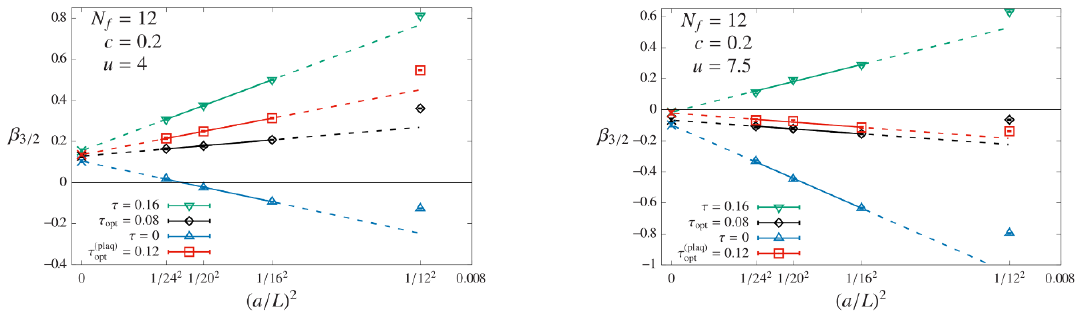
Figure 10 . Linear ( a=L ) 2 ! 0 extrapolations of the s = 3 = 2 discrete (cid:12) function for c = 0 : 2, at two values of u = 4 (left) and 7.5 (right) on either side of the IR (cid:12)xed point. In each plot we compare (cid:28) 0 = 0 and 0.16 to the optimal (cid:28) opt = 0 : 08, and also include results from the plaquette discretization of the energy density E ( t ) in eq. (2.3) at the corresponding optimal (cid:28) (plaq) Unlike (cid:12)gure 2, the di(cid:11)erent (cid:28) 0 do not extrapolate to consistent values in the ( a=L ) 2 ! 0